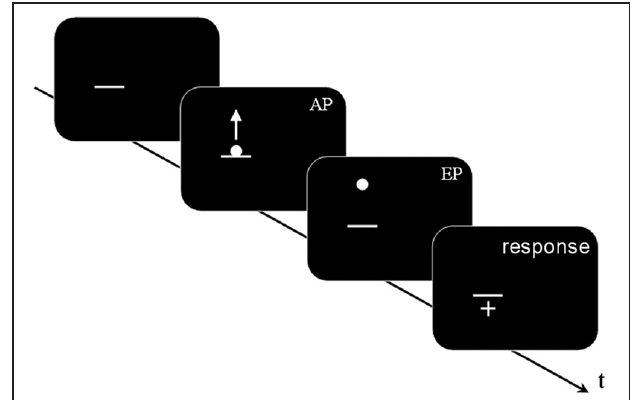
FIGURE 2 | A schematic representation of stimulus sequence (Experiments 1 and 2, not to scale): a dark gray horizontal line was displayed; after a random delay comprised between 0.8 and 1.6s, a white dot appeared, centered on the horizontal line. The dot moved upwards following one of the two kinematic laws (BIO or NBIO): the motion was visible from the Appearing Point (AP) to the Ending Point (EP). After a delay of 0.4s the mouse cursor (shaped as a white cross) appeared in the center of the screen. In Experiment 1 the AP was located after the 40% of the whole trajectory, whereas in Experiment 2 the AP corresponded to the Starting Point. Participants’ task was to move the mouse cursor where they think (Experiment 1) or see (Experiment 2) the motion started (i.e., on the estimated SP) and to confirm their response by pressing the mouse button, which started the next